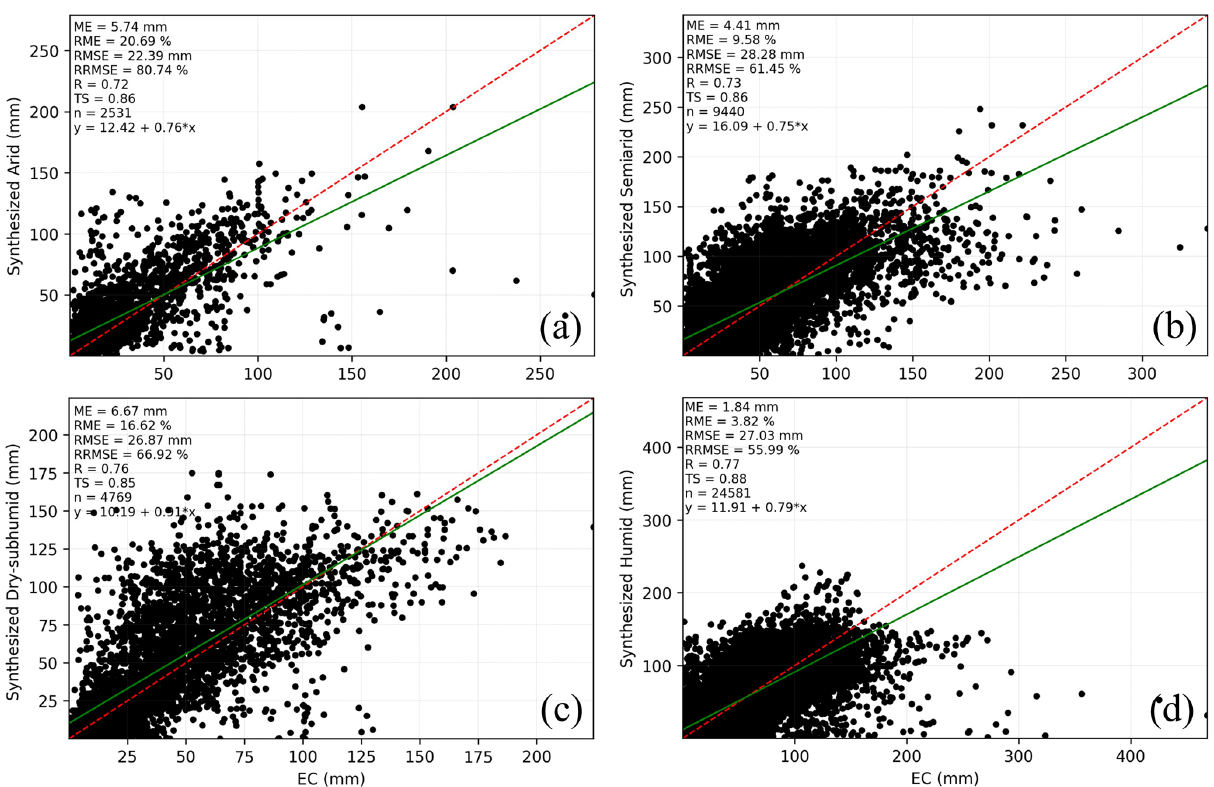
Figure 17. Monthly synthesized ET against flux EC ET aggregated for all sites for each climate class (arid: a ; semiarid: b ; dry subhumid: c ; humid: d ).